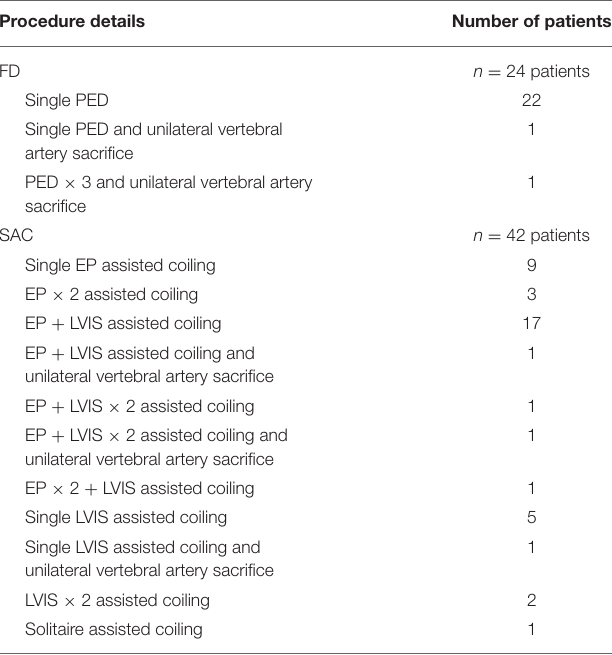
TABLE 2 | Endovascular procedure